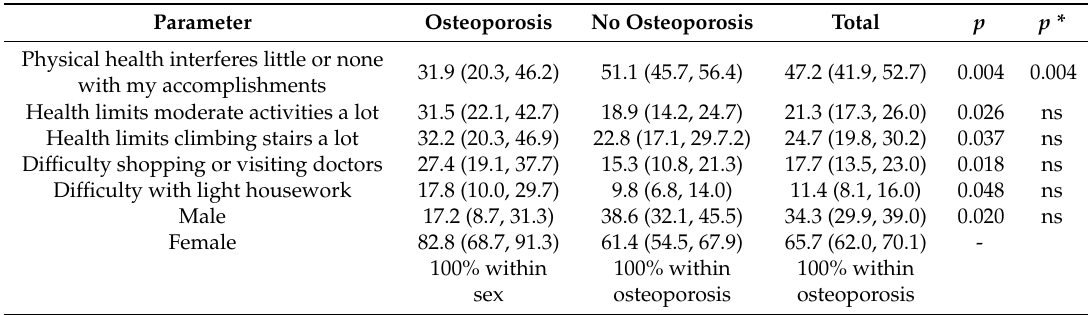
Table 2. Chi-square analysis of difficulties with physical function and percent osteoporosis.